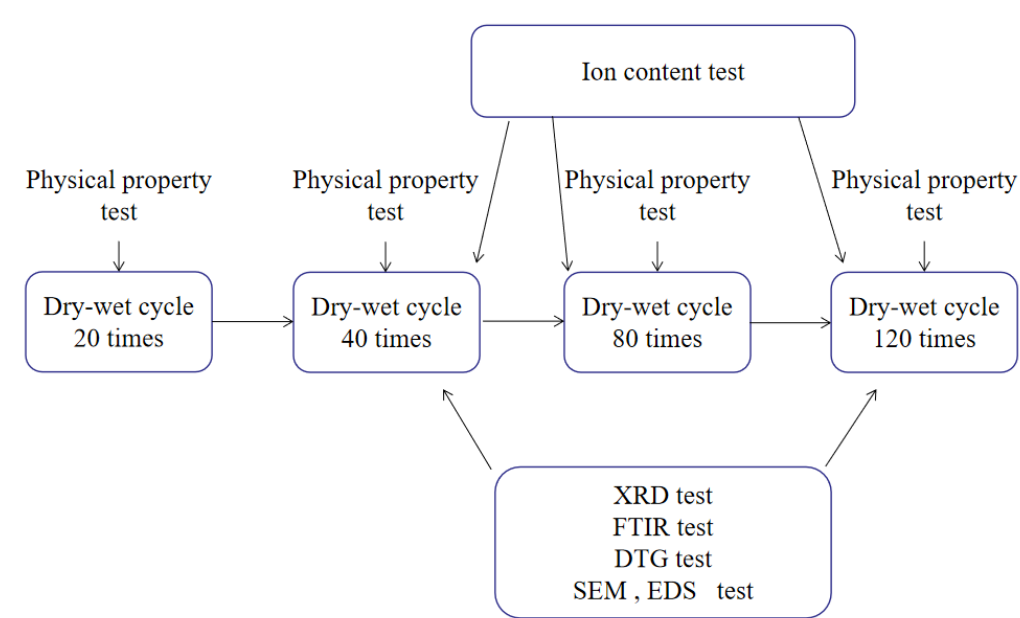
Figure 4. Specific test flow during the dry-wet cycle.